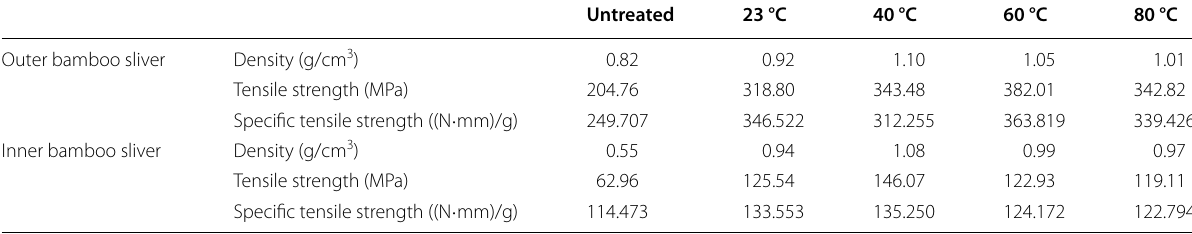
Table 1 Density, tensile strength, and specific tensile strength of outer and inner bamboo